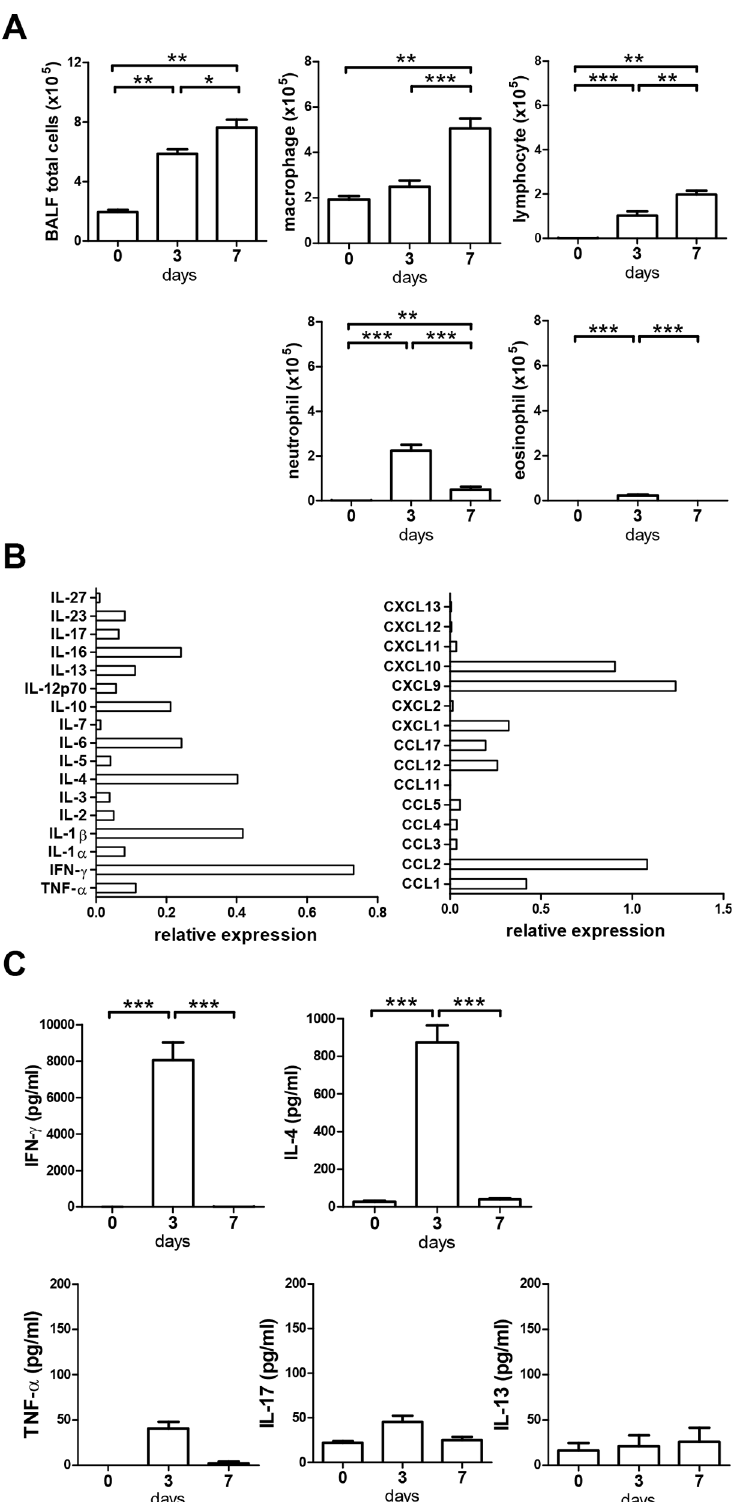
Fig 2. Intranasal α -GalCer administration induced acute inflammation in the lung. Mice were intranasally administered with vehicle or α -GalCer. BALF was collected at days 0, 3 and 7. (A) BALF total cells and the absolute numbers of macrophages, lymphocytes, neutrophils, and eosinophils were measured at the indicated time points. (B) The relative expressions of cytokines and chemokines compared to positive control (set to a value of 1) of the assay kit in BALF at 3 days after α -GalCer administration of mice